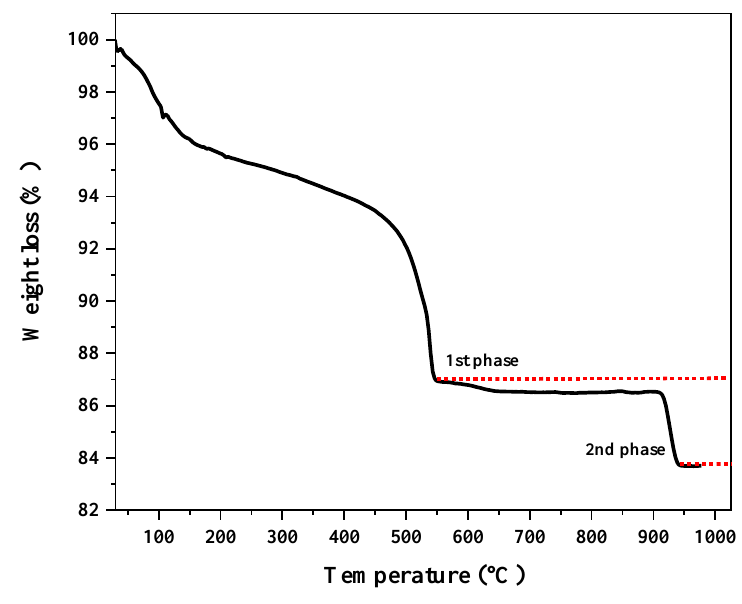
Figure 1. TGA profile of MnO 2.